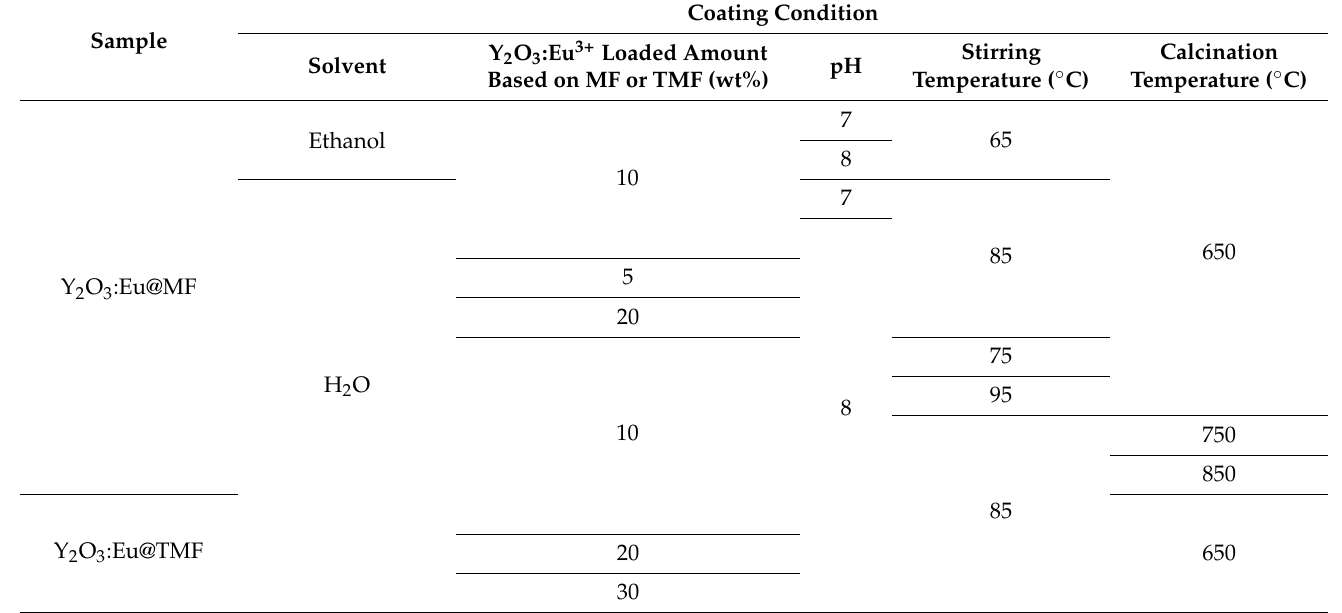
Table 1. Coating conditions of Y 2 O 3 :Eu@MF and Y 2 O 3 :Eu@TMF red phosphors. Sample